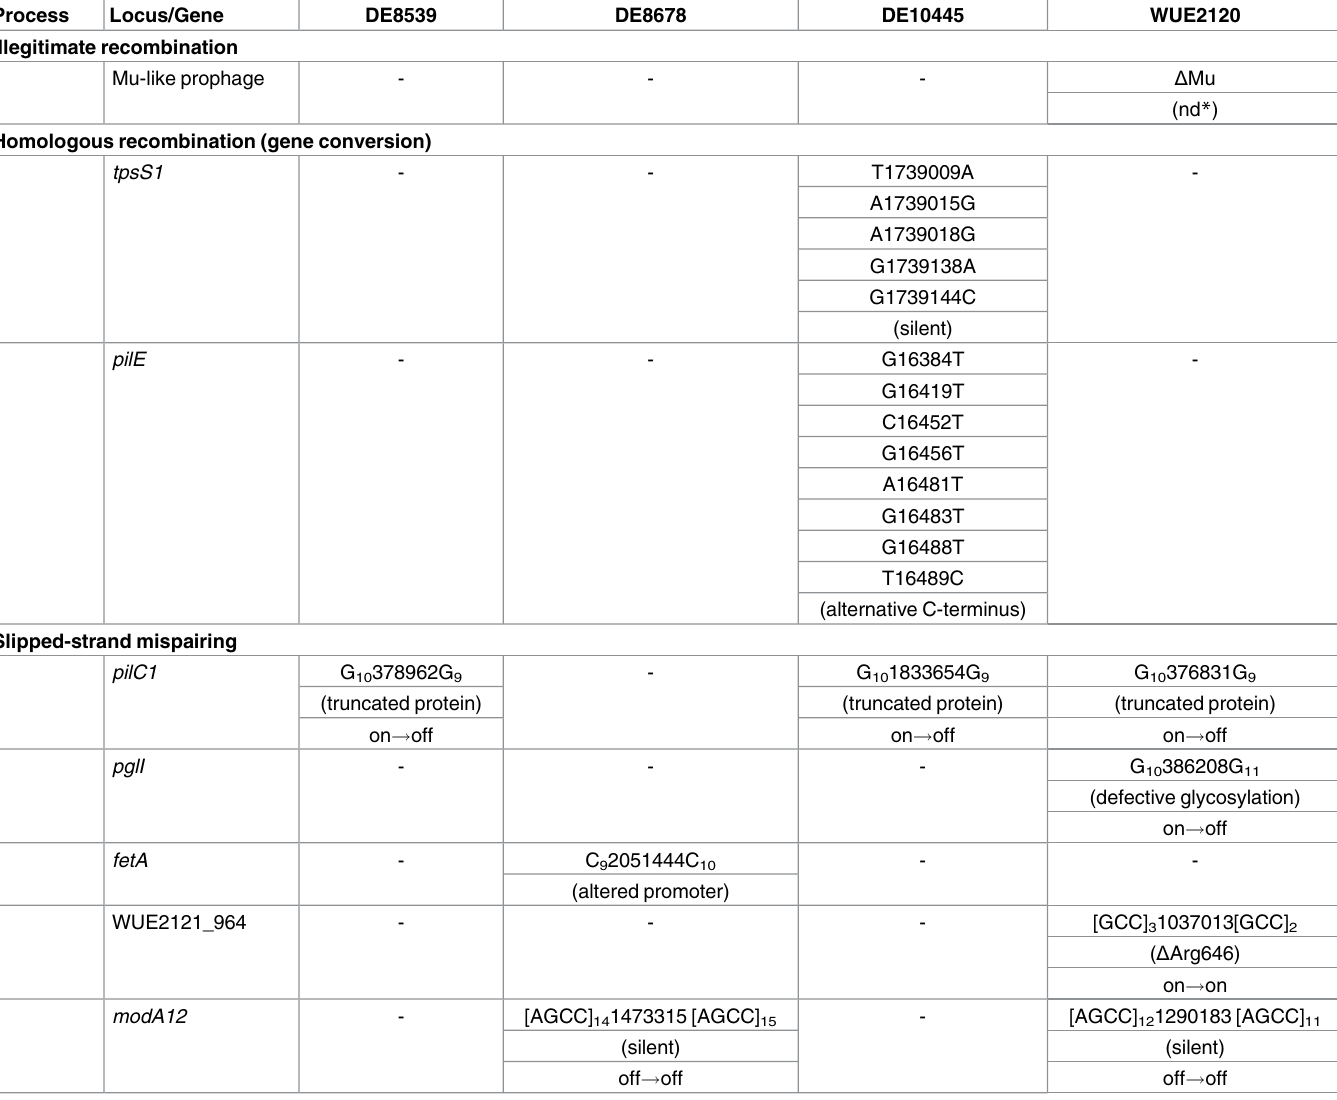
Table 2. Genomic differences in blood isolates relative to the corresponding throat isolates. For each gene and locus, the inferred phenotypes of the blood isolates at the protein level are given in parenthesesand below the resultingexpressionor functionalchanges(“on” or “off”).